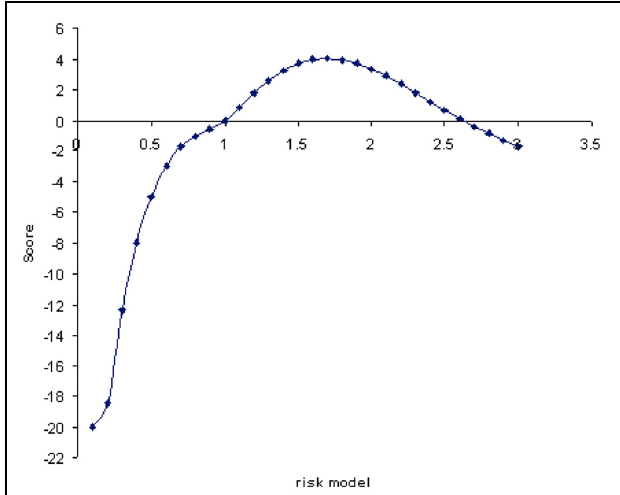
FIGURE 3 | ANCESTRYMAP risk model ( x -axis) plotted vs. genomewide average LOD scores. The maximum likelihood risk model is 1.7 with a genomewide score LOD of value 4.04 ( y -axis). The average LOD score for all risk models is